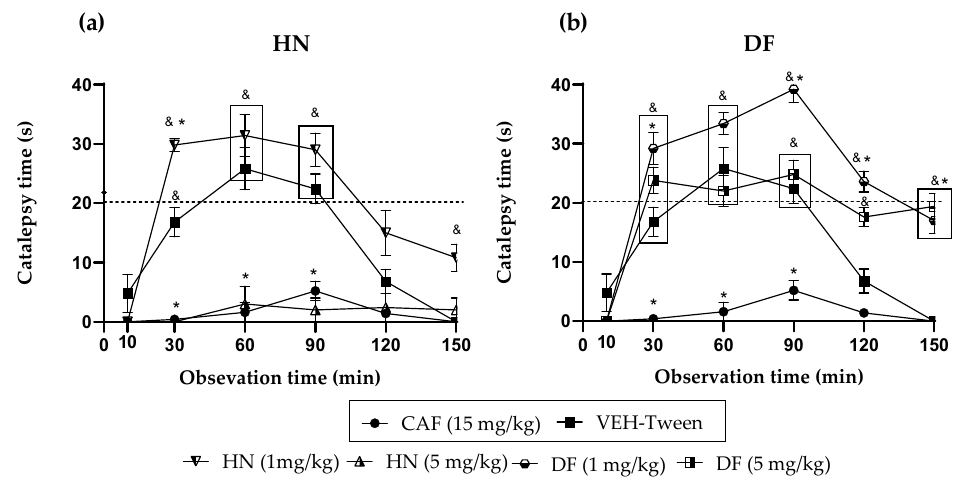
Figure 3. Effect of coumarins isolated from T. lucida on the cataleptic state (haloperidol-HAL-0.5 mg/kg i.p.), in Bar test (BT) on mice. ( a ) Herniarin (HN); ( b ) Dimethylfraxetin (DF). ANOVA followed by Dunnett’s Test ( x ± S.E.M., n = 5); * p < 0.05 in comparison with the VEH-Tween group, & p < 0.05 in comparison with caffeine (CAF).